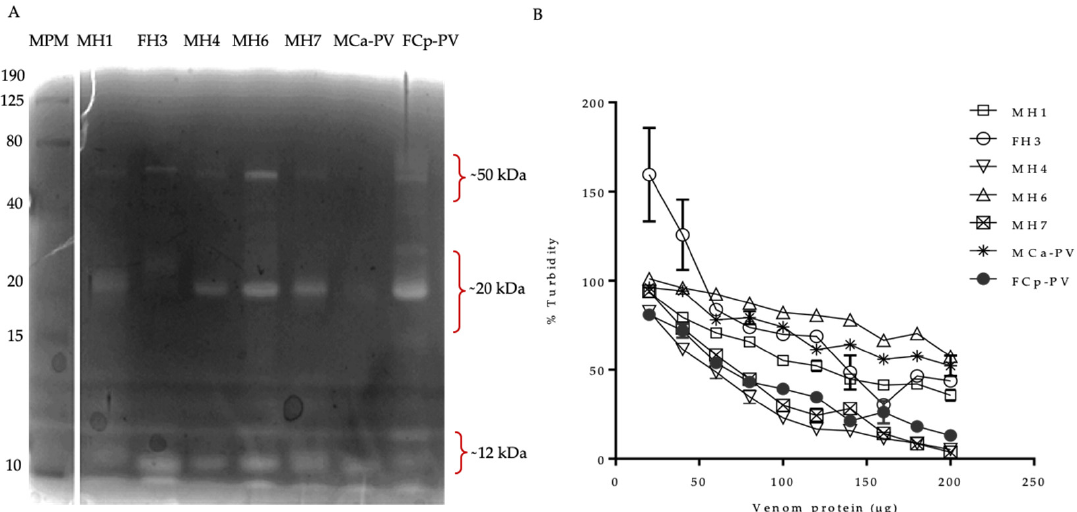
Figure 6. Hyaluronidase activity. ( A ) Hyaluronidase zymography of 100 µg of venom protein. ( B ) Enzymatic activity of hyaluronidases using 20–200 µg of venom protein. Hybrids of the first hybridization event (11 years old): MH1, FH3, and MH4; hybrids of the second hybridization event (10 years old): MH6 and MH7; pooled venom of MCa-PV and FCp-PV. The MWMs are to the left.